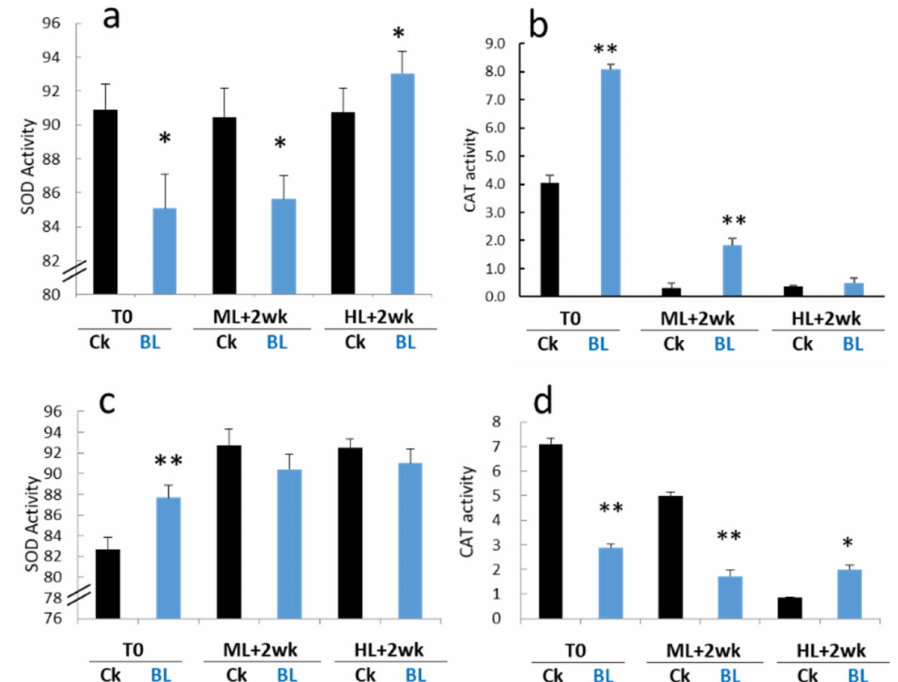
Figure 6. Blue light acclimation a ff ects the antioxidant enzyme activities of moth orchids. ( a , b ) Young orchid seedlings, ( c , d ) mature 2.5” potted plants. ( a , c ) Superoxide dismutase (SOD) activities, the Figure 3 legend. Error bars represent the standard error of the mean ( n = 3). *, p < 0.05; **, p <